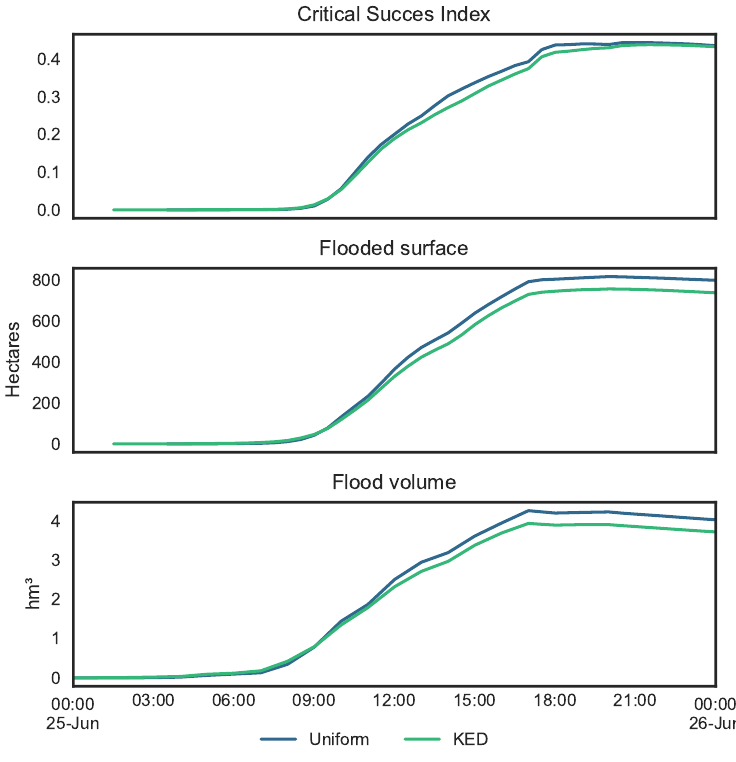
Figure 12. Evolution in time of the flood volume, flooded surface and Critical Success Index. The flooded surface and CSI are calculated for water depths above